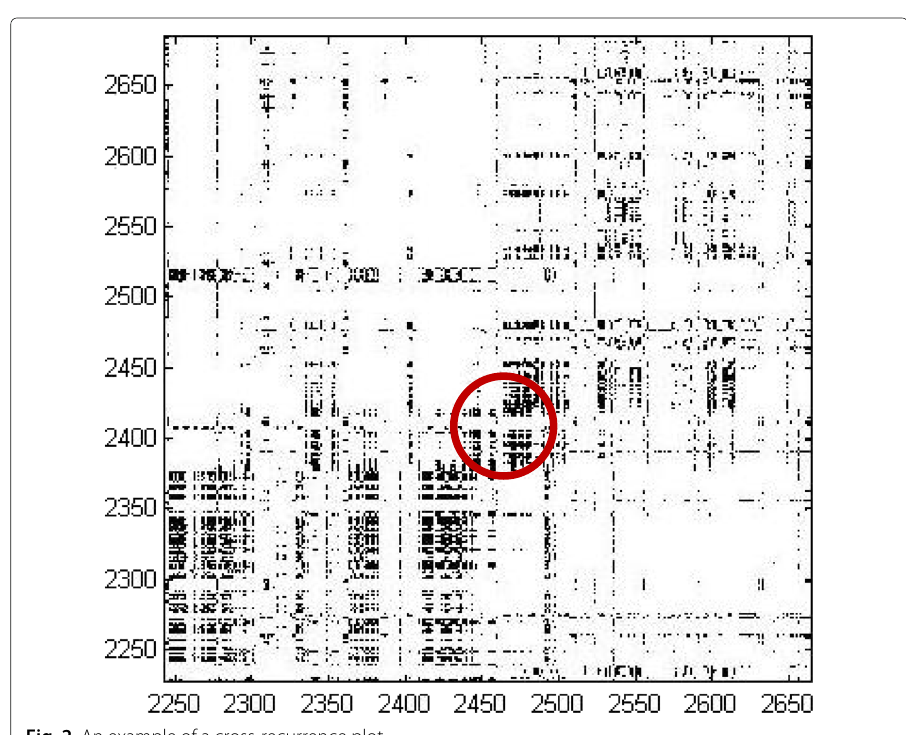
Table 1 Some CRP textures and their meanings Texture Meaning Fading portions to the upper left and lower right corner Data is non-stationary, i.e., data has slowly varying parameters Single and isolated recurrence points Reflect random and strong fluctuations in the data but are not considered a unique sign of chance or noise Horizontal/vertical lines and rectangular clusters Marks a time length which a state does not change or changes very slowly or the process is halted at a singularity in which the dynamic is stuck in paused states (called “laminar” or “trapped” states) Bands of white space Indicate abrupt changes or transitions that may reflect an underlying state changes Two collaborators uninterruptedly looked at two different spots on the screen Empty regions The states within this period do not occur at any other times (e.g., states are unique or far from normal) Diagonal lines parallel to the main diagonal Segment of one trajectory runs almost parallel to another segment (i.e., the trajectories visit the same region of the phase space at different times) Collaborators looked at the same spot on the screen